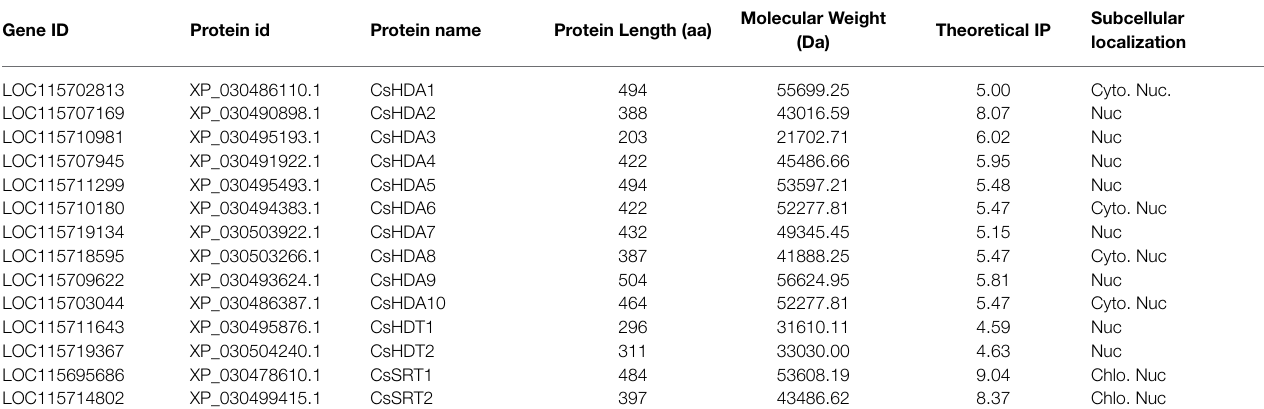
TABLE 2 | Description of the HDACs in C. sativa